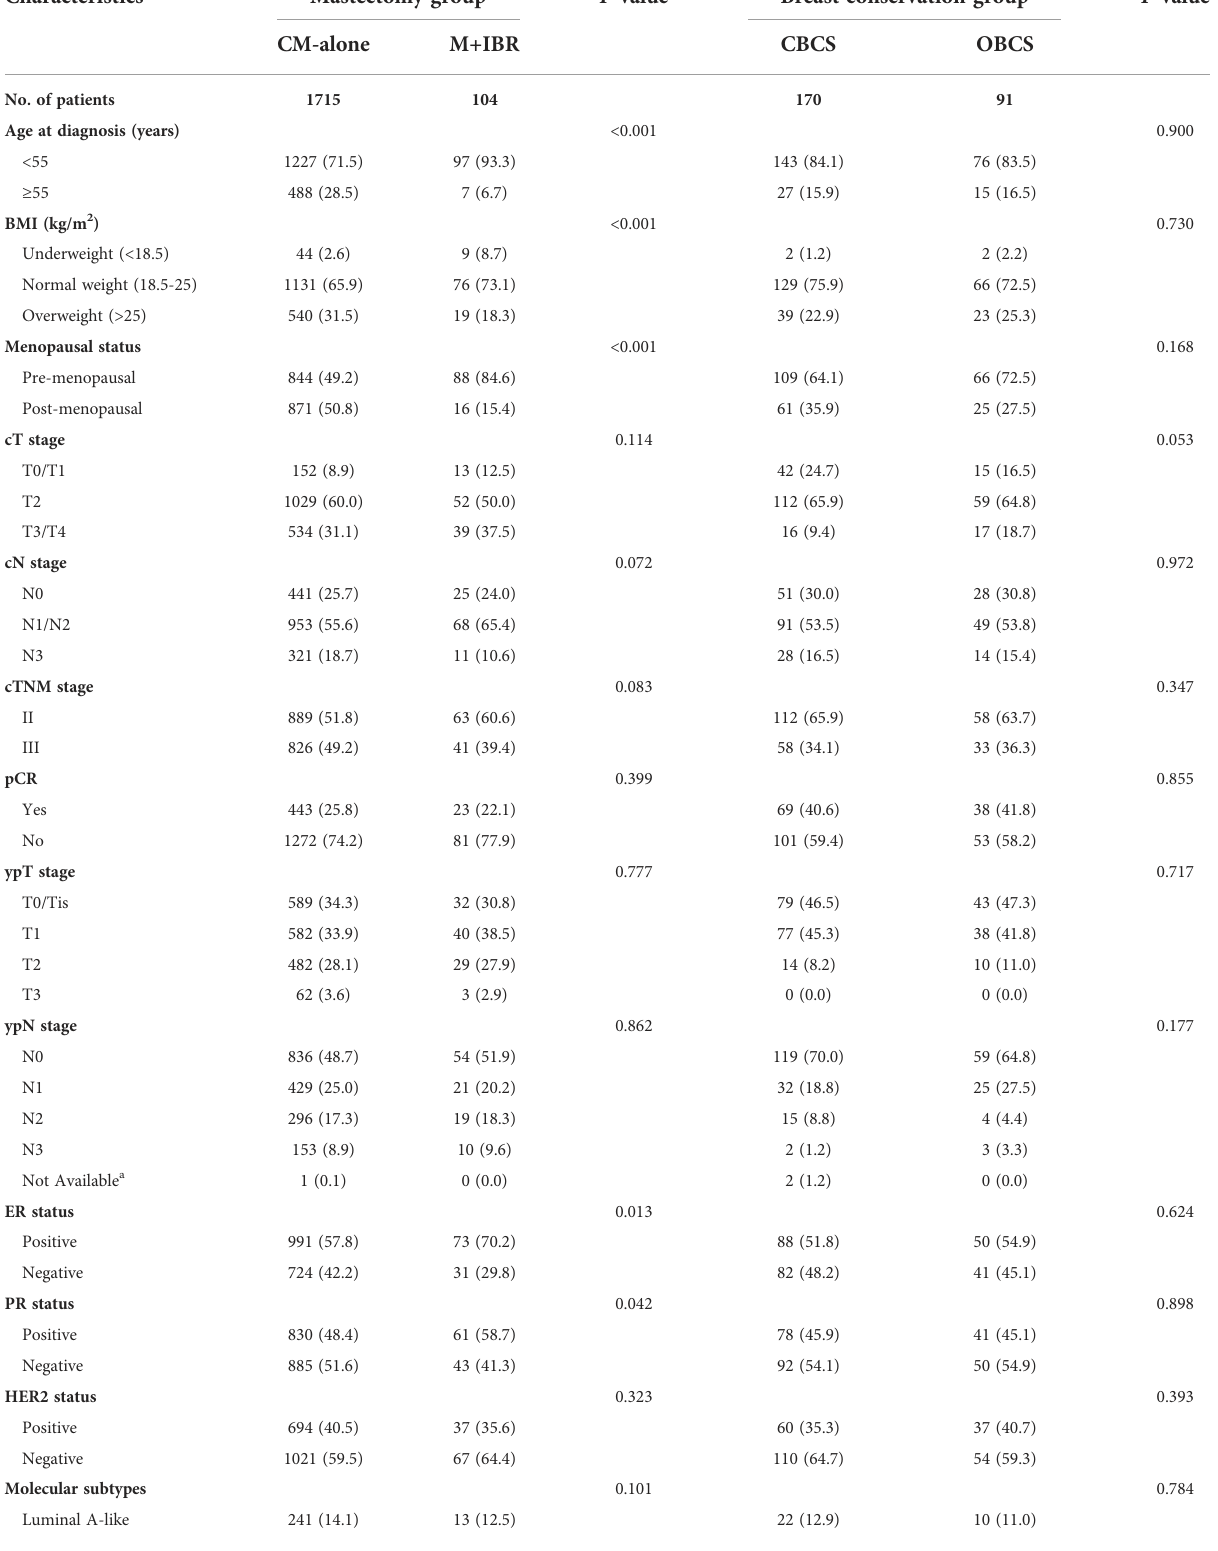
TABLE 2 Comparison of characteristics of patients receiving different surgical interventions in mastectomy and breast conservation